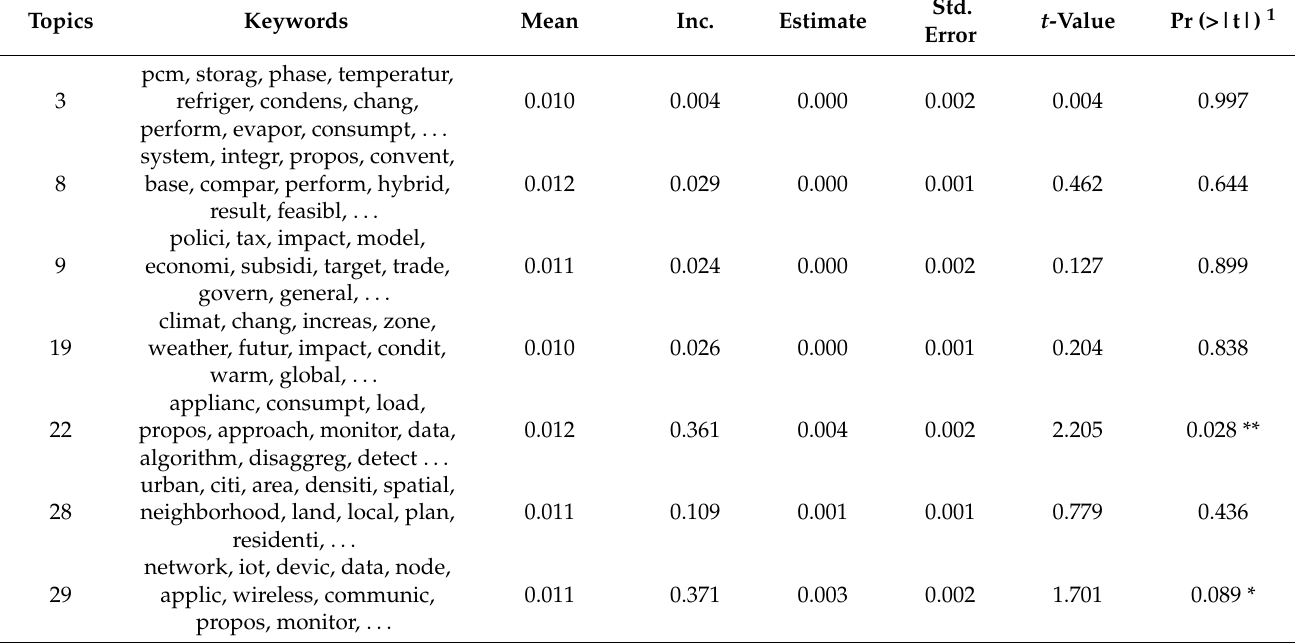
Table 1. Topics selected as Strong